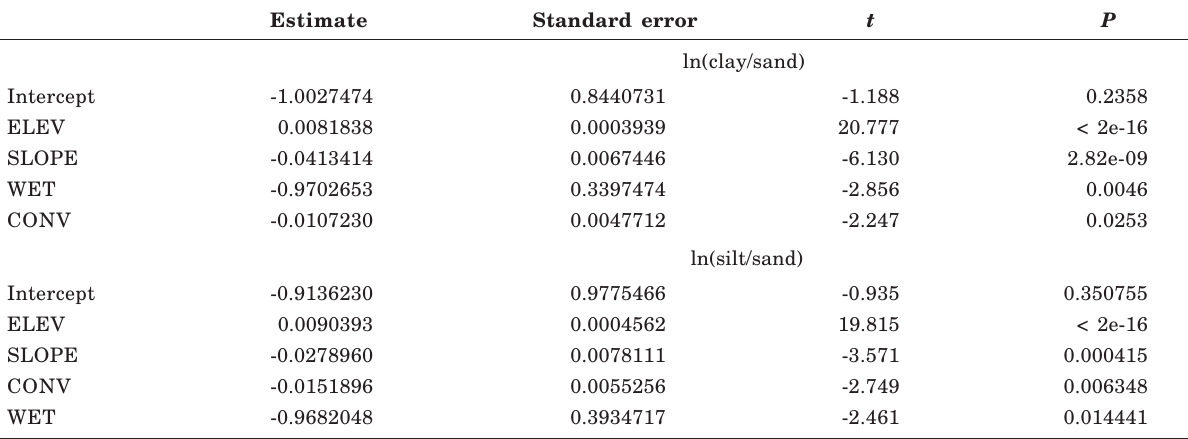
Table 1. Regression coefficients for predictive models PMs-1 built to predict the particle-size distribution (%) of the soils of the entire catchment